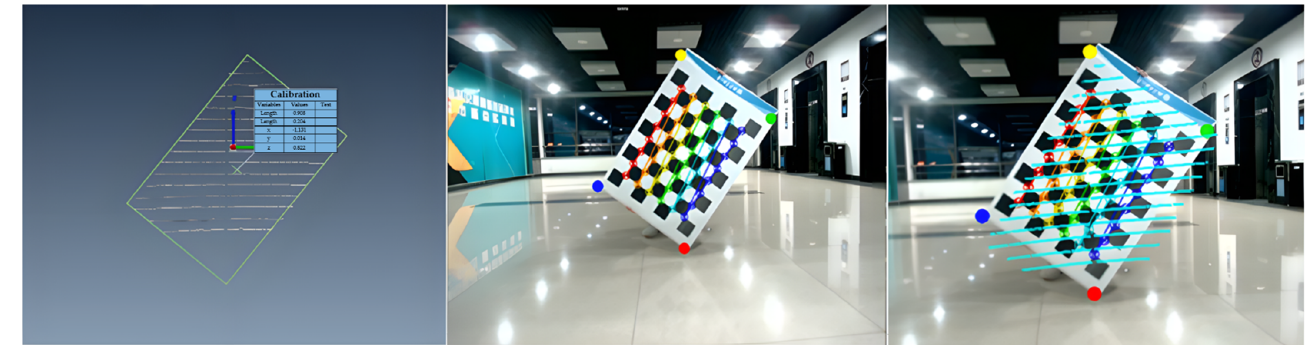
Figure 6. The coordinate system calibration of the multi-source sensors. (2) Point cloud data and pixel data matching The R-Tree algorithm is used to associate and match the detection box of the point cloud and the image to project the point cloud data to the pixel plane. According to the IoU of the detected target in the point cloud space can be determined since there are several detection boxes, respectively, in each frame of image and point cloud data. We select